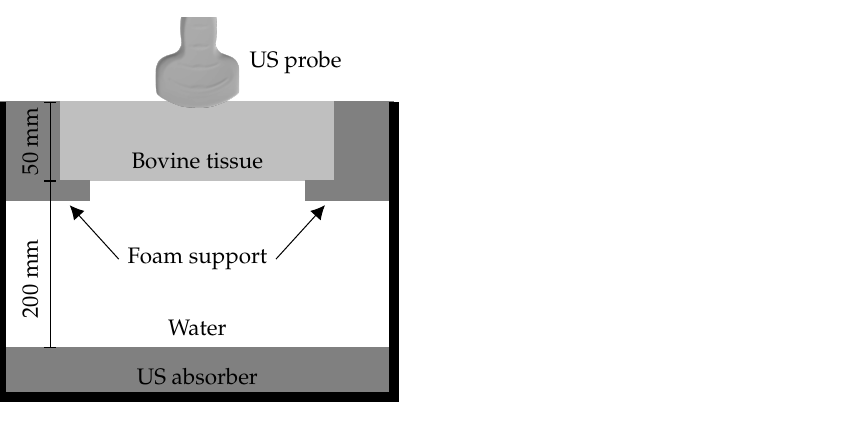
Figure 6. Cross-sectional diagram of the phantom used for determining tracking accuracy in